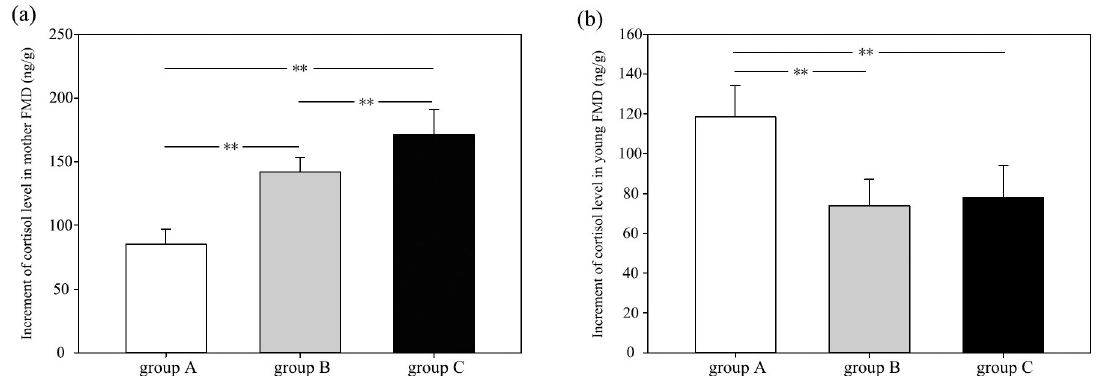
Fig 1. Increment of the fecal cortisol concentration of female (a) and infant FMD (b) before and after separation at different separation times (group A: 80 days, group B: 90 days, group C: 100 days).